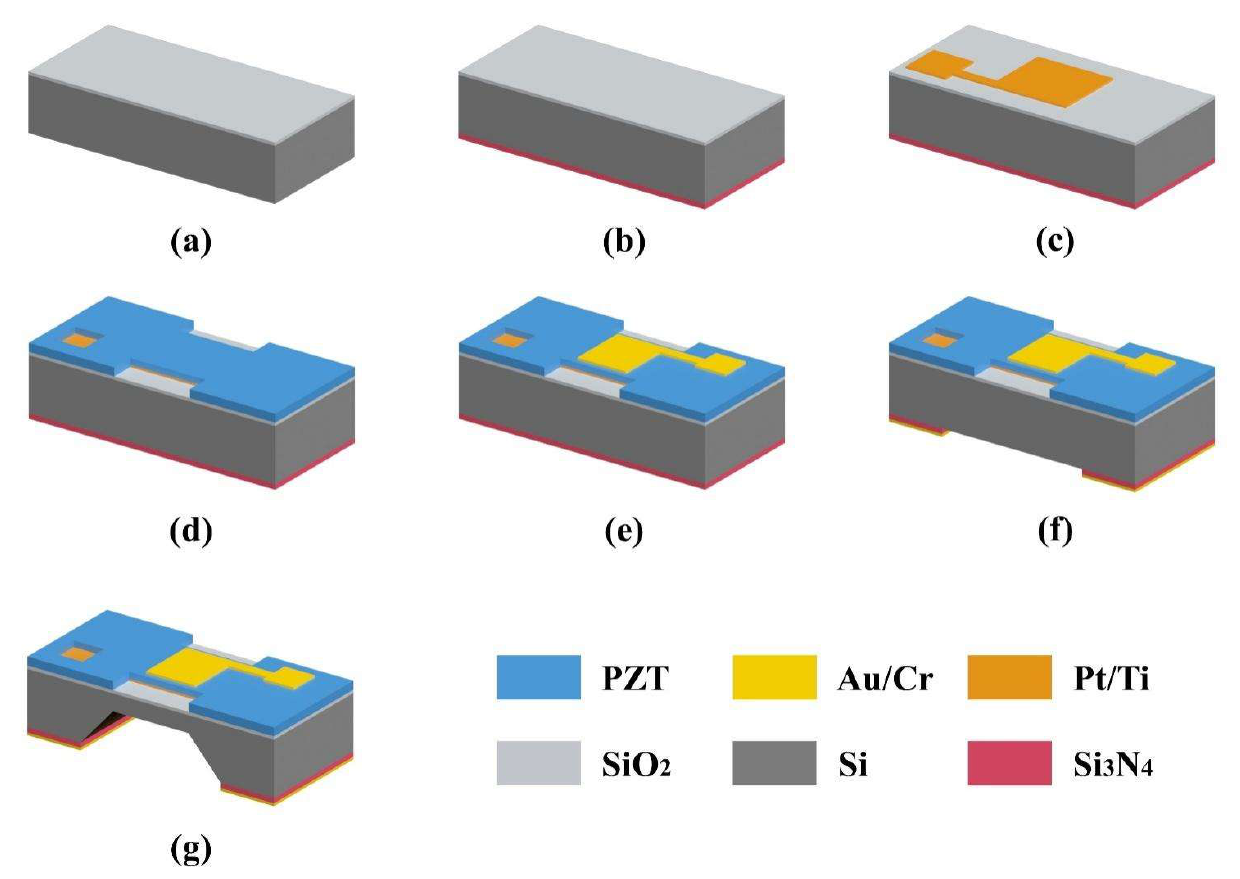
Figure 4. Fabrication process of the pMUT.